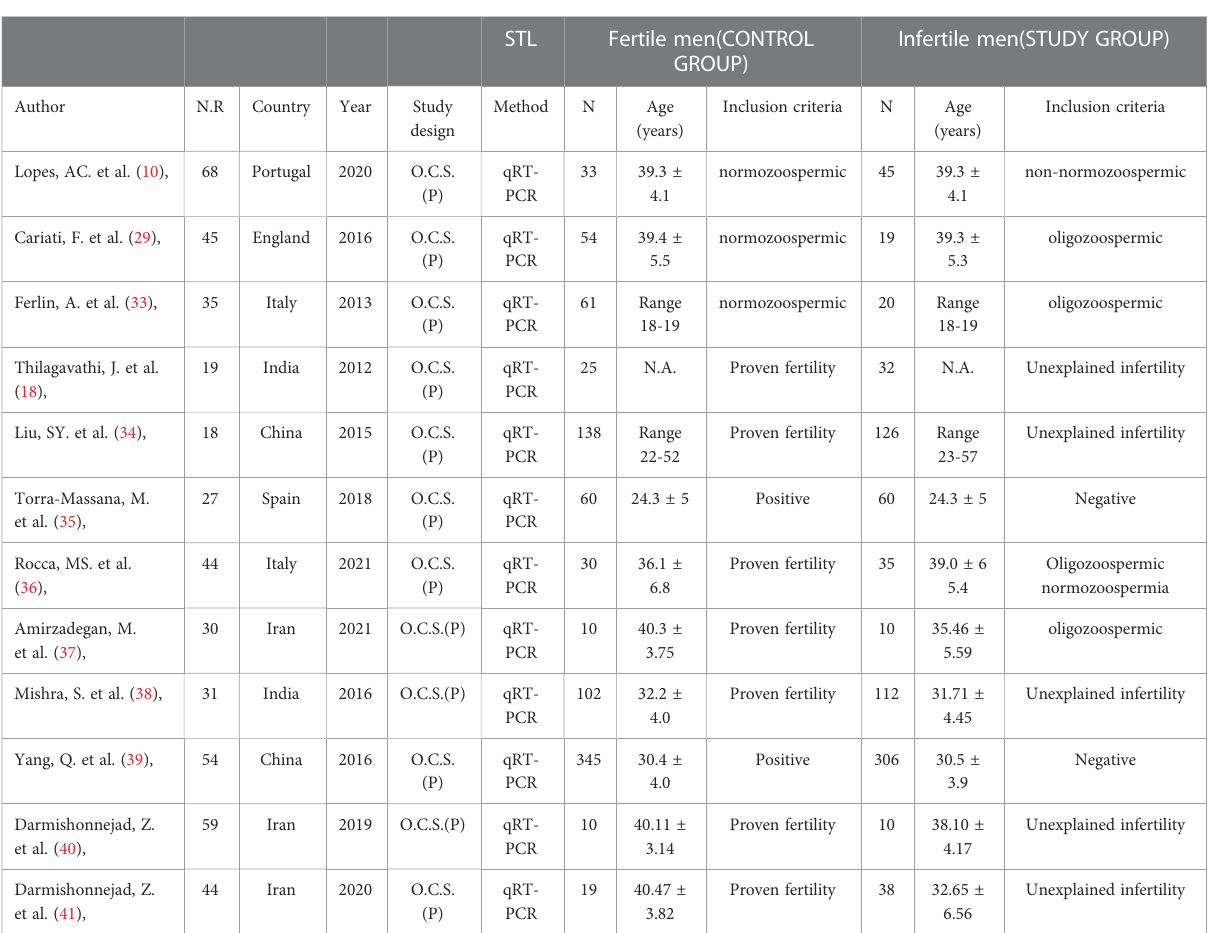
TABLE 1 Characteristics of studies included in the